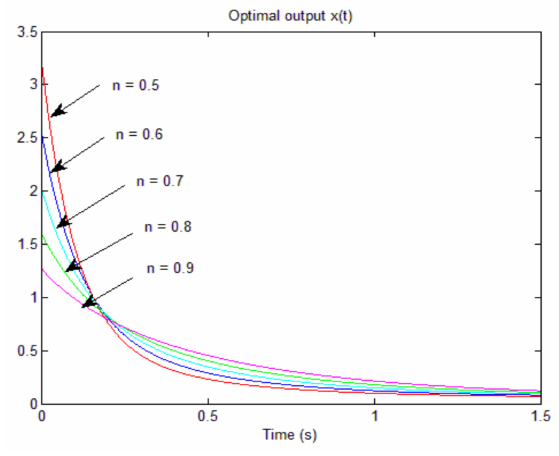
Figure 7. Optimal pseudo-state x ( t ) .